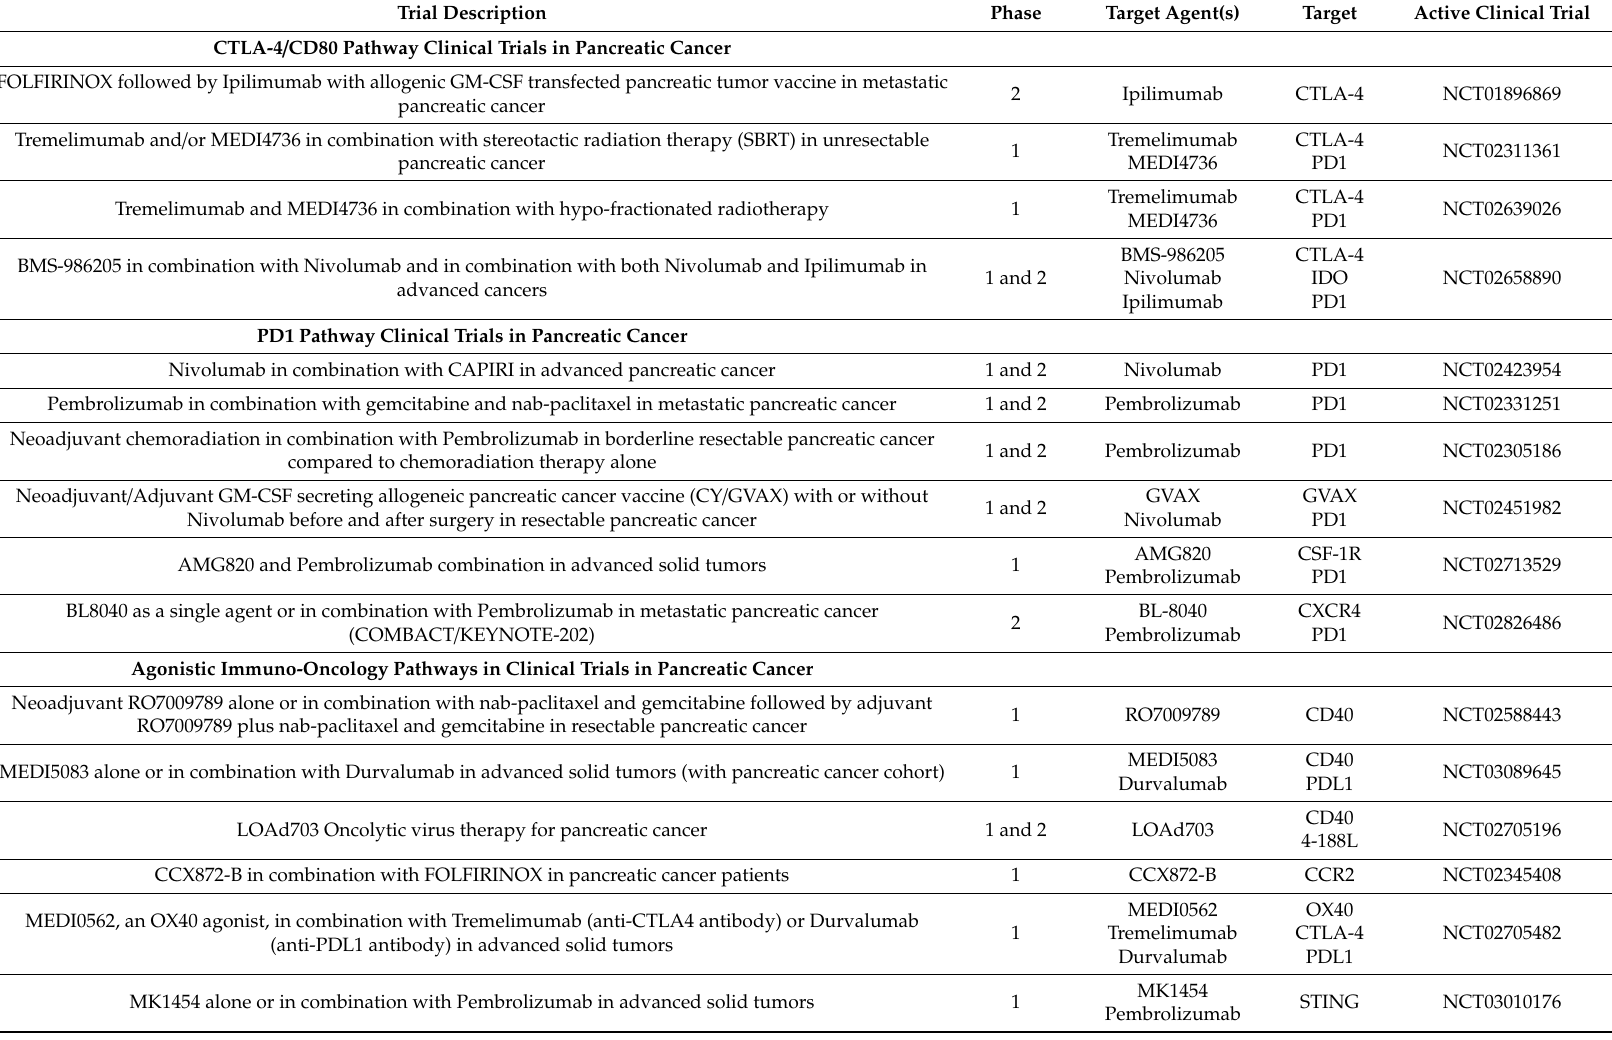
Table 1. Early phase clinical trials investigating novel immunotherapy targets in pancreatic